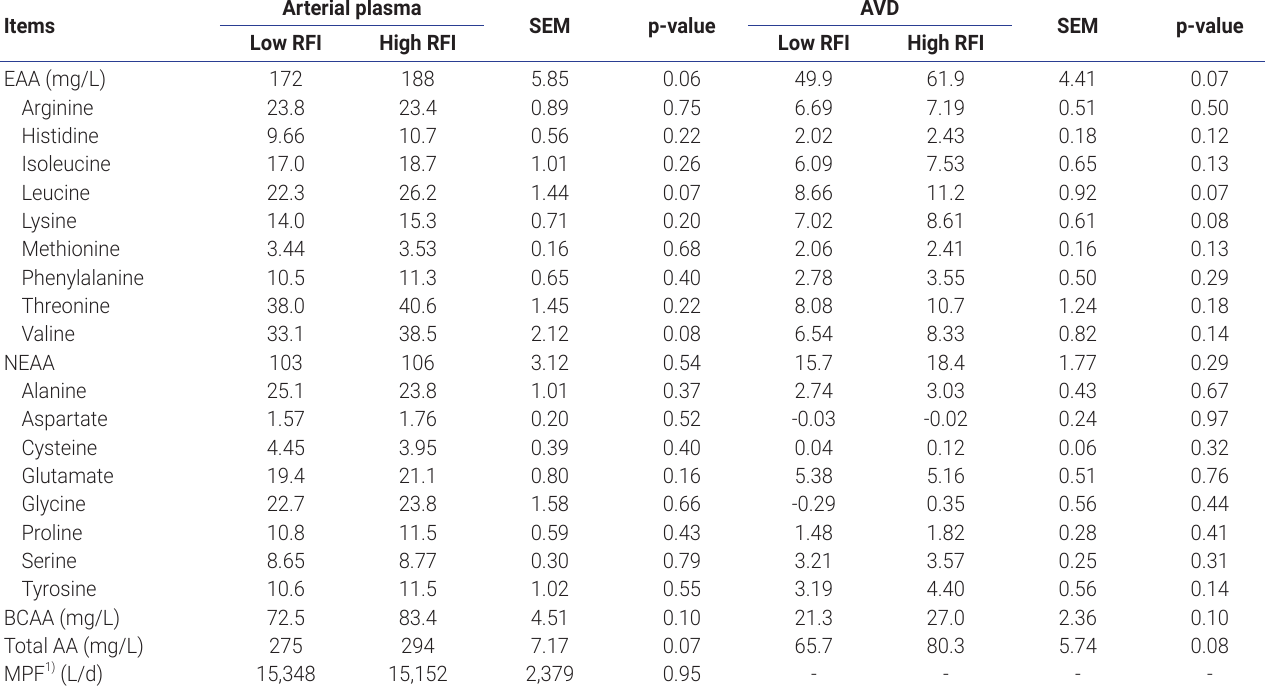
Table 4. Arterial plasma concentration and arteriovenous difference of amino acid, and mammary plasma flow in lactating cows selected for phenotypic divergence in residual feed intake